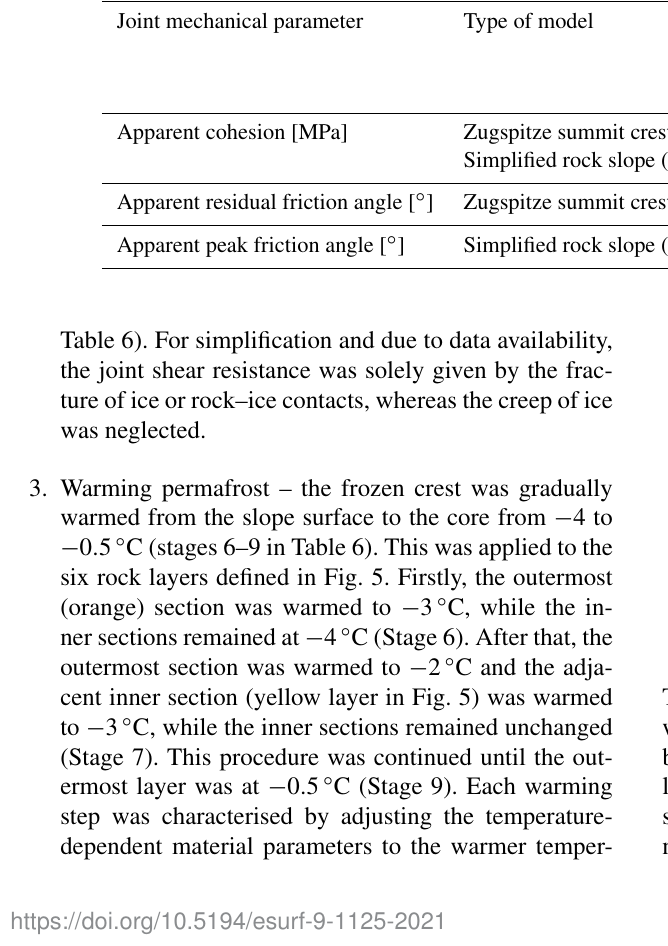
Table 7. Implemented strength properties for ice-filled and frozen ice-free joints during the initial stage of rock bridge destruction, repre- sented by a joint persistence of 30% to 90%. The different cohesion and friction values are calculated after Jennings (1970) and depend on the estimated relative percentage of rock bridges and joints. The corresponding values at a joint persistence of 100% are shown in Table